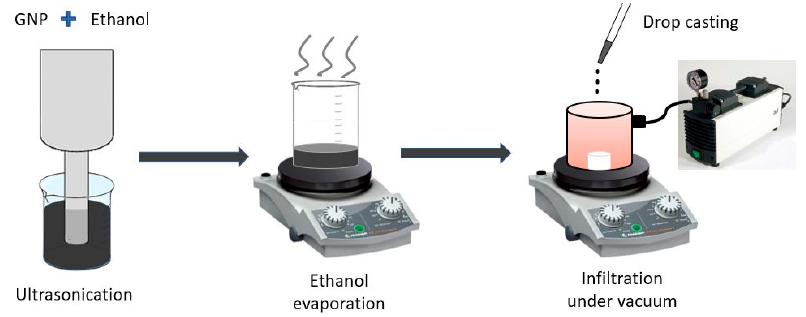
Figure 2. Schematic representation of the foam infiltration process.